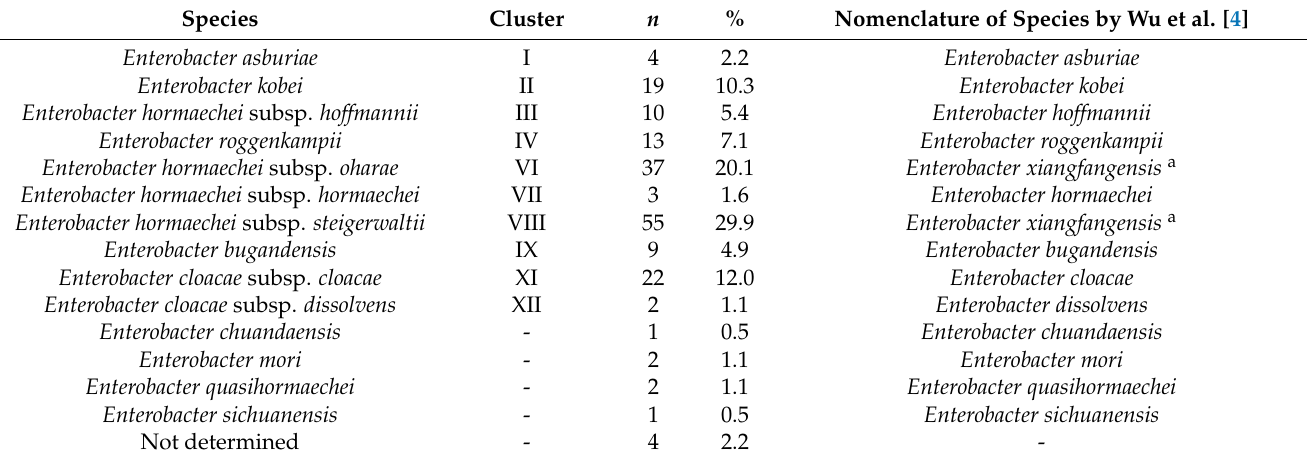
Table 1. Species identification using hsp60 gene sequencing of Enterobacter